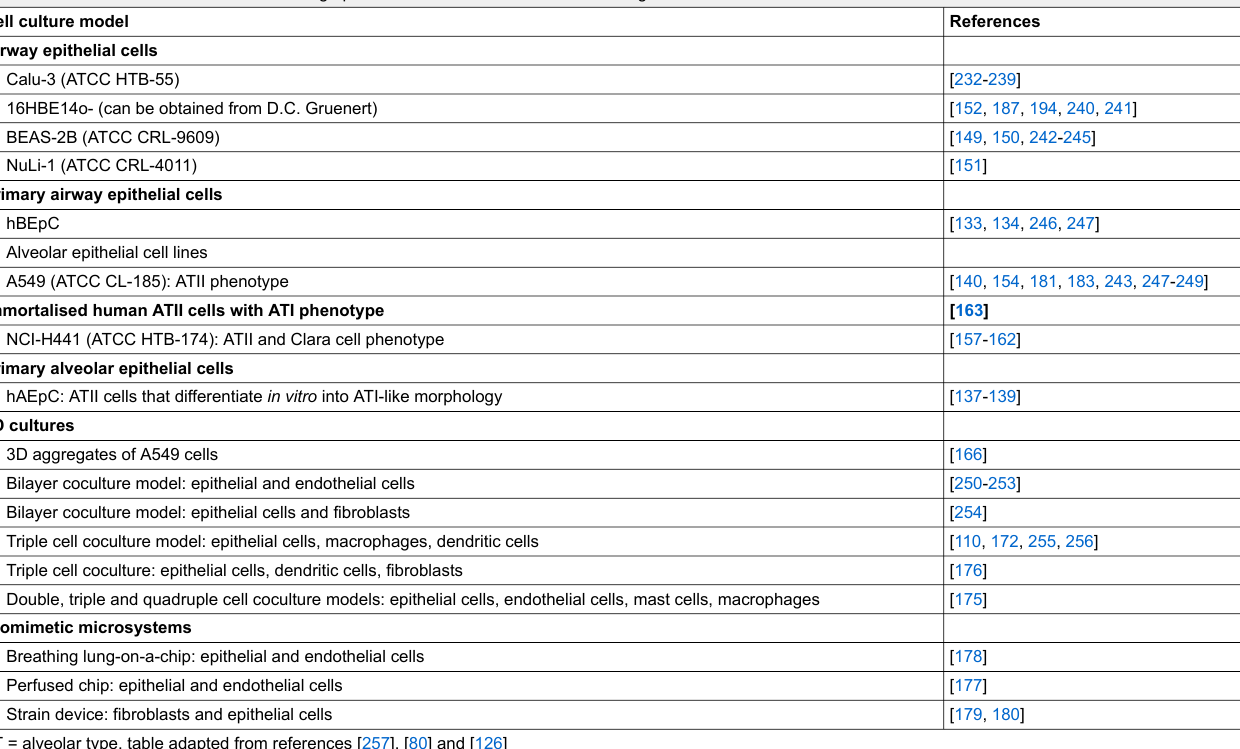
Table 1: Human cell culture models mimicking epithelial barriers found in the human lung. Cell culture